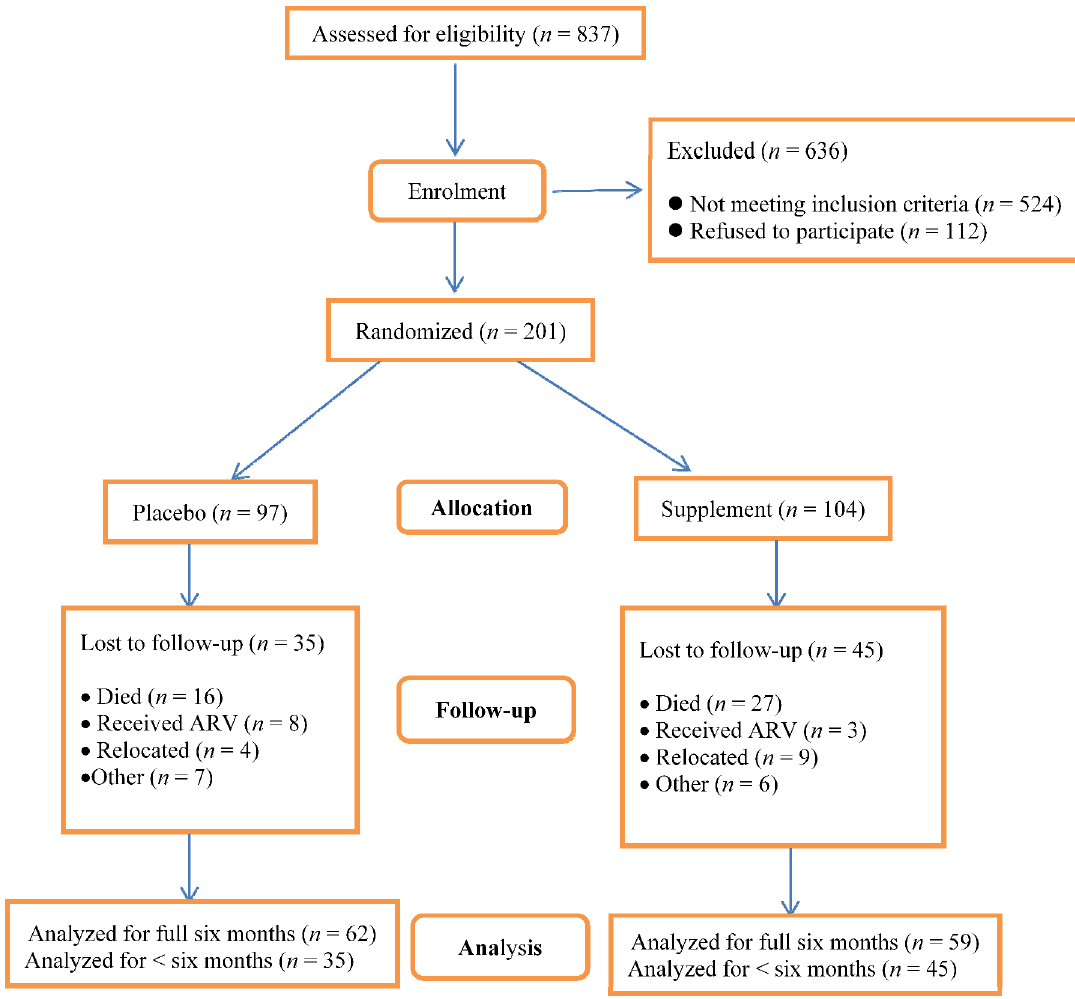
Figure 1. Assessment for eligibility, enrolment and losses to follow-up by treatment group. Analysis for the number of episodes of respiratory symptoms and of diarrhea was only conducted among children who were followed up for three or more months. The number of episodes was then divided by the number of months of follow-up. Analysis for changes in anthropometric indices, serum micronutrient concentrations and CD4 lymphocyte counts was only performed in children who had completed the